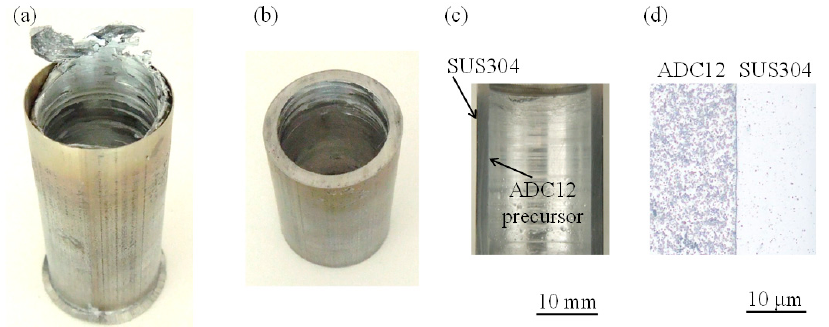
Figure 4. ( a ) As-fabricated precursor-coated steel tube. ( b ) machined precursor-coated steel tube before foaming and ( c ) its cross section. ( d ) enlarged image of bonding region of ( c